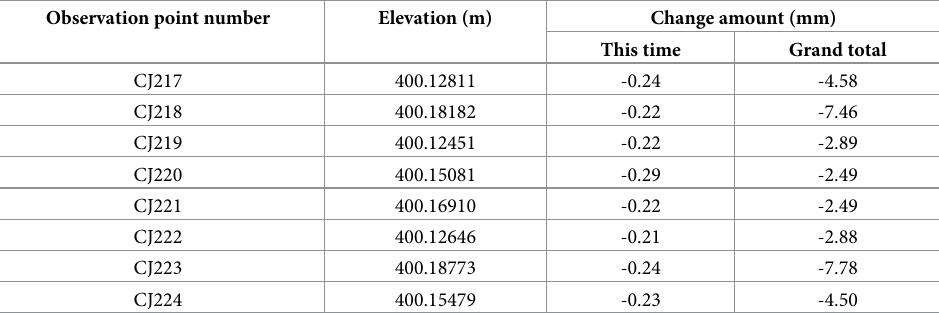
Table 2. Dependent project monitoring